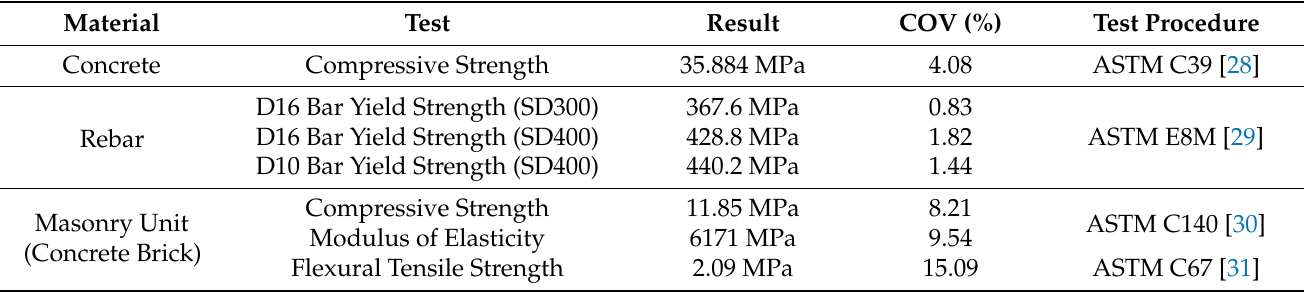
Table 2. Material Table 2. Material properties.